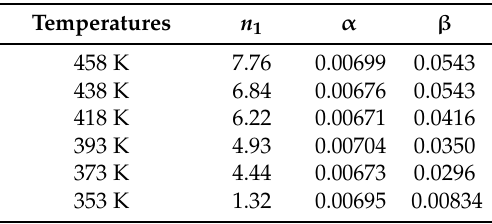
Table 2. Experimental parameters of 2219 aluminum alloy at different aging